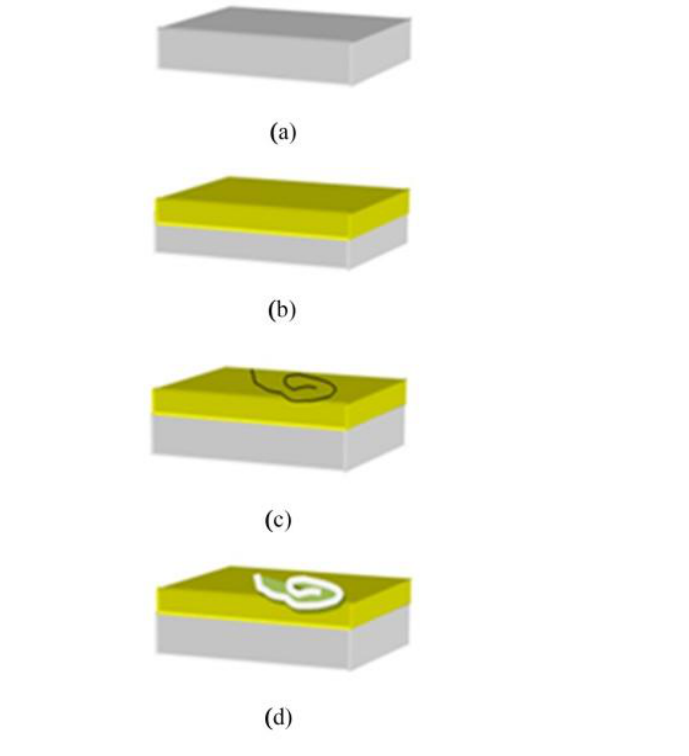
Figure 1. Schematic diagram showing the sample ( a ) cleaning silicon surface with standard method; ( b ) Aluminium deposition with thermal evaporation method; ( c ) DNA strands transfer on Al surface; ( d ) Removal of DNA strands off the surface reveals imprint of strands on